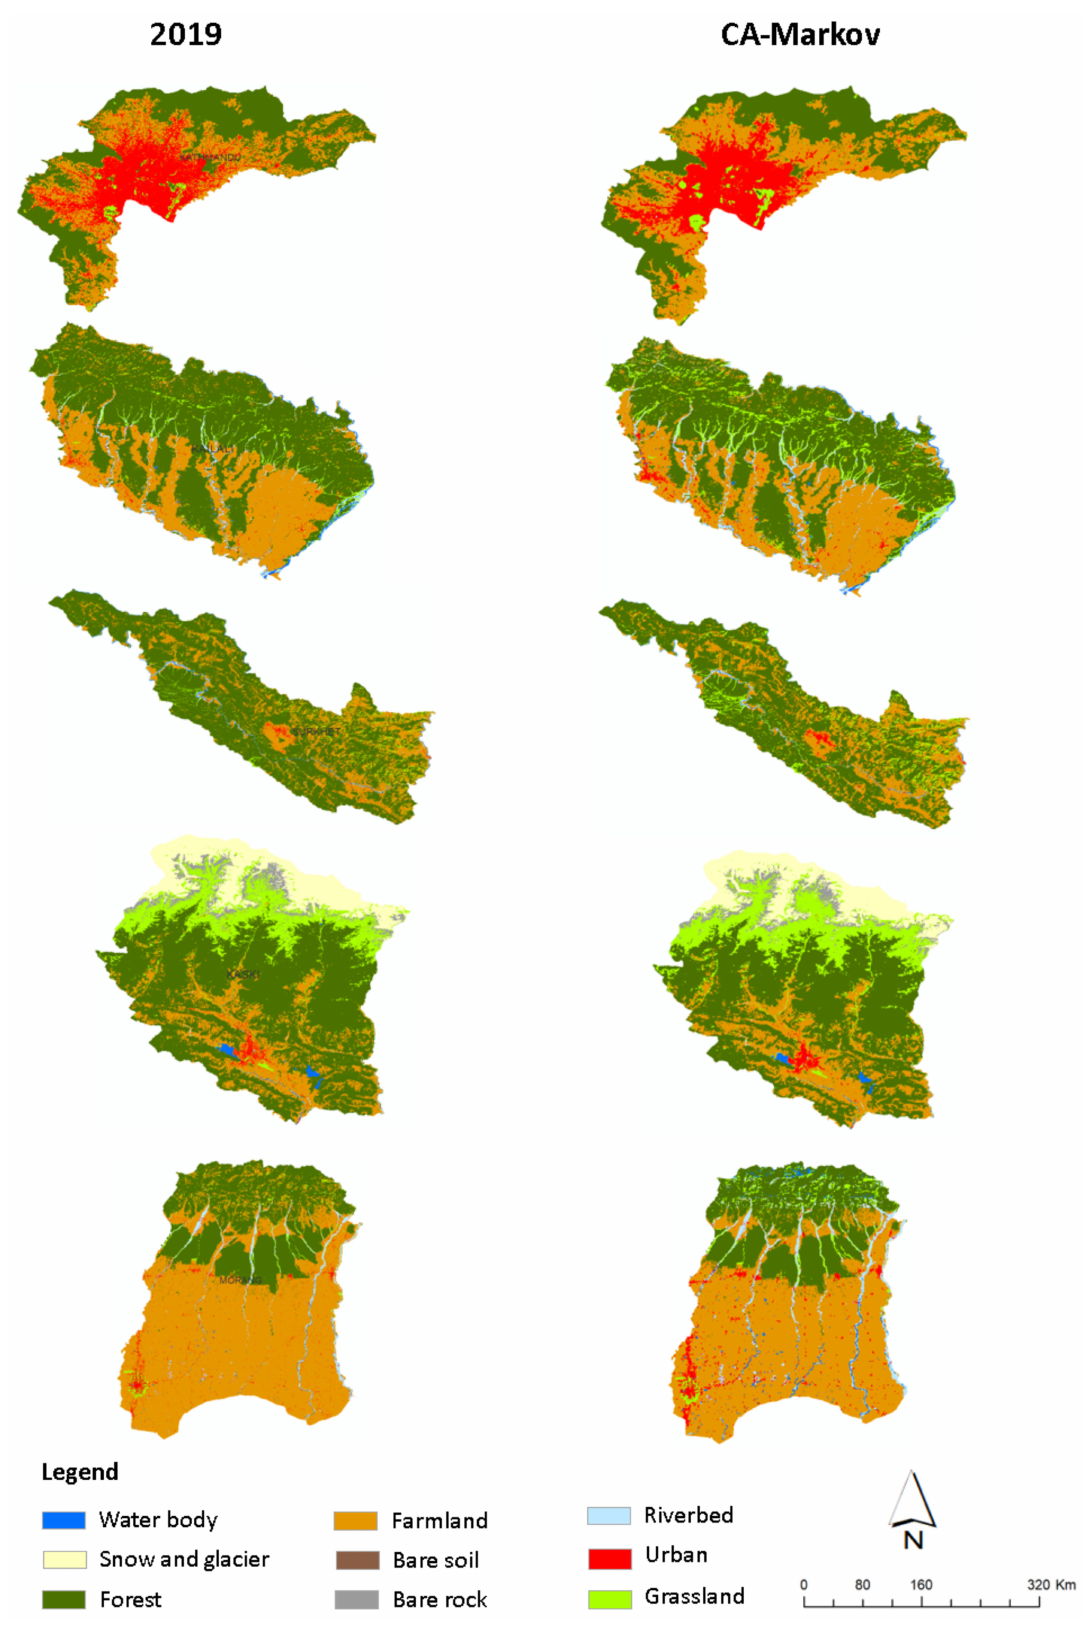
Figure 10. Land cover data of 2019 and the prediction of the CA-Markov simulation for 2019. The results of Kathmandu, Kailali, Surkhet, Kaski and Morang are shown